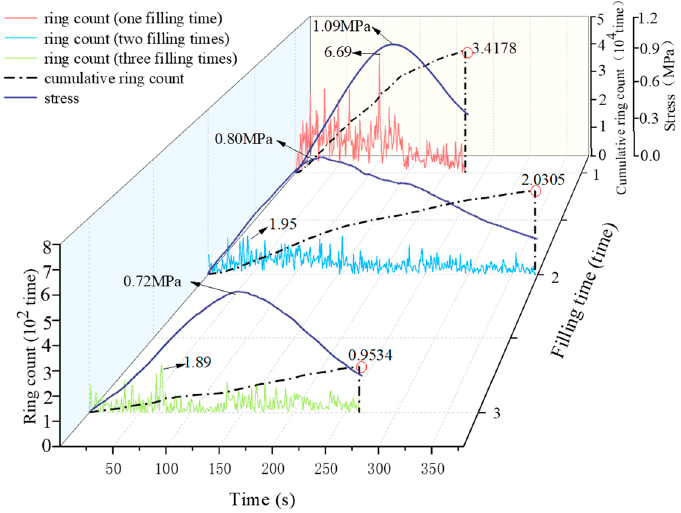
Figure 4. Ringing count of LCTB with different filling times.